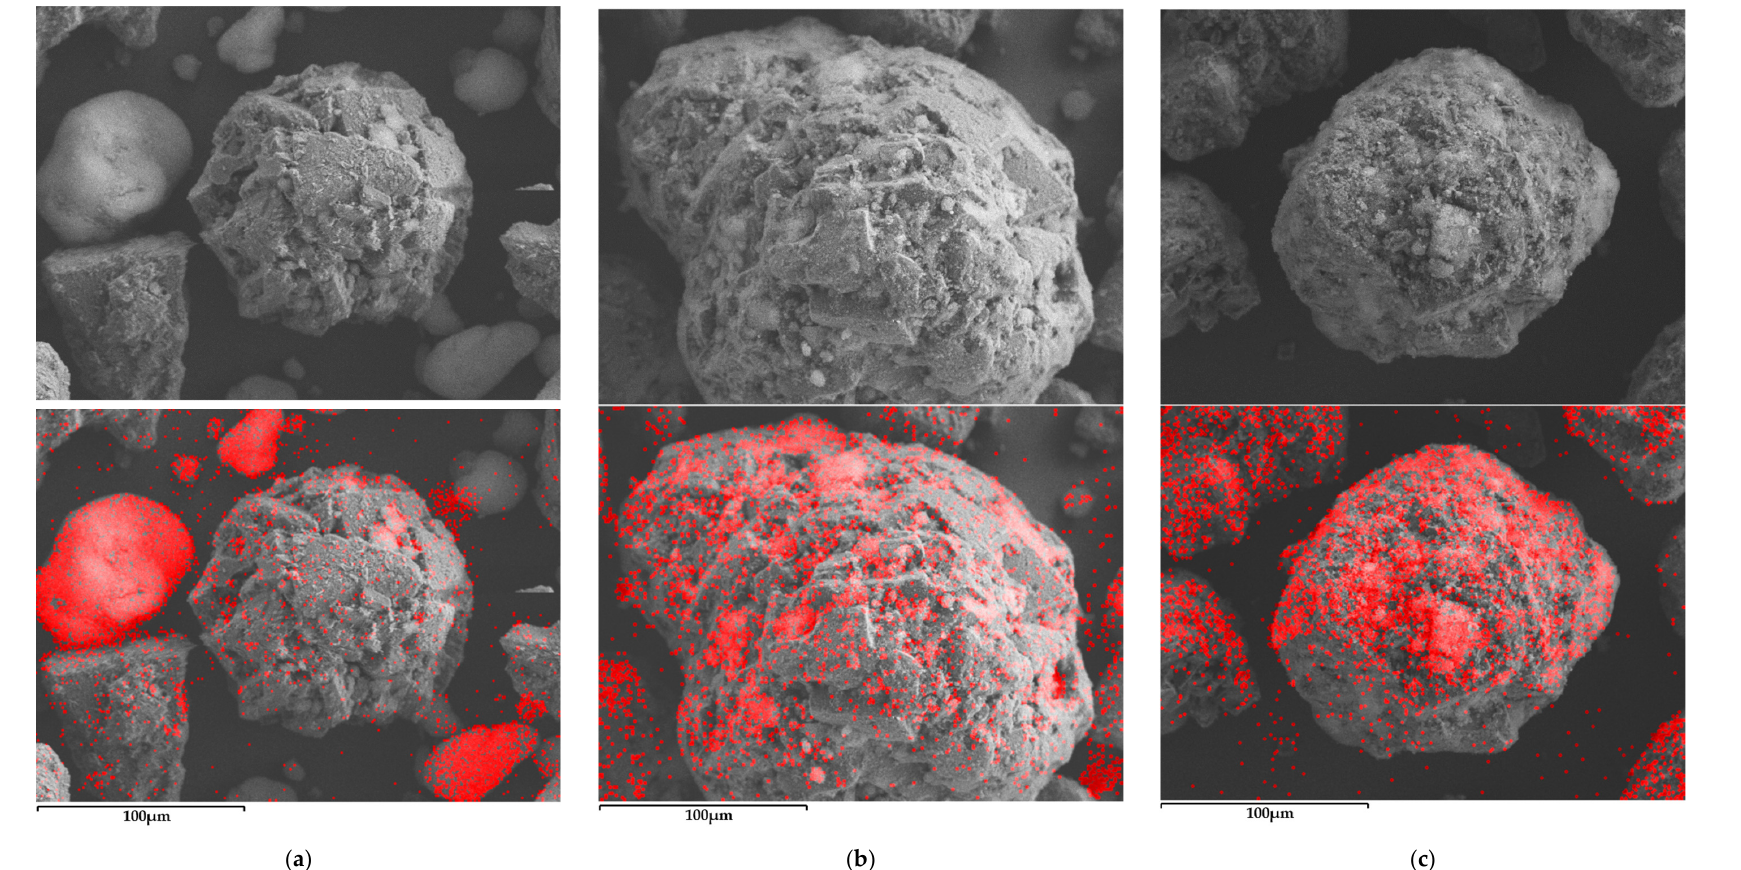
Figure 3. SEM (top) and EDS mapping (bottom) at 1K magnification of FFL particles with 1.5% A200P ( a ) after mixing in a V ‐ Blender, after processing in the conical mill 4 times at ( b ) 476 rpm and ( c ) 1762 rpm. Red dots on bottom row are EDS mapping results of silicon.